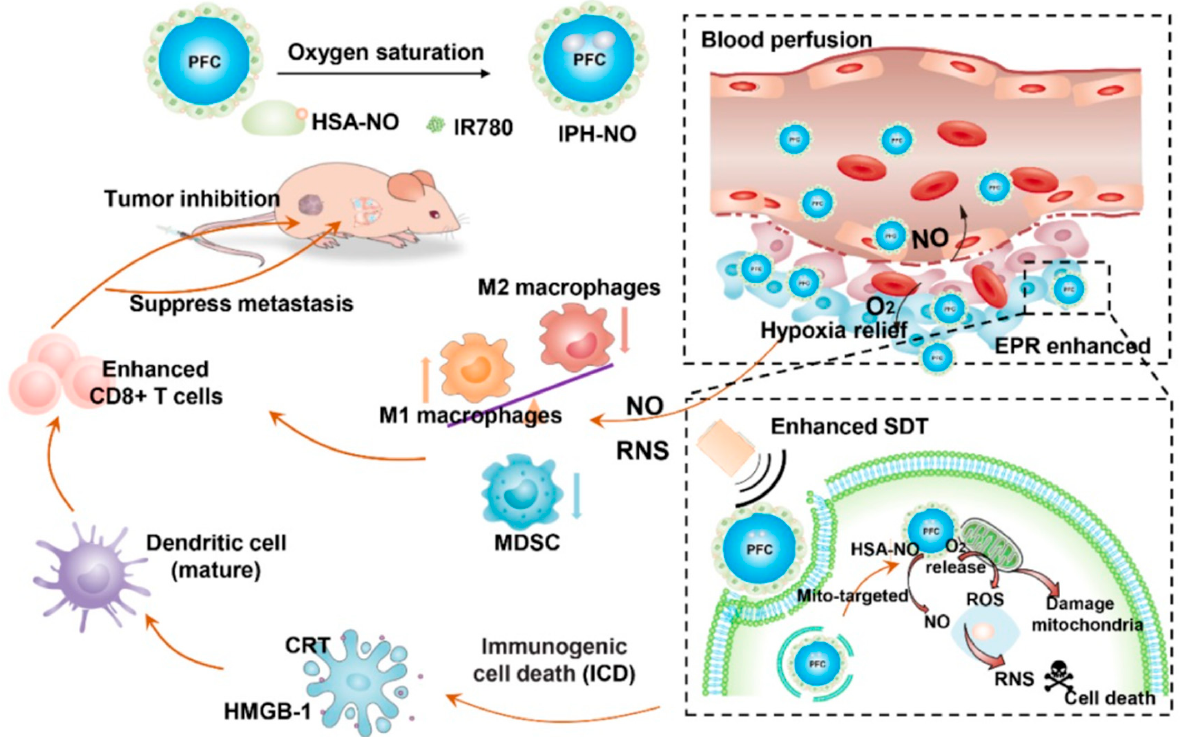
Figure 9. Scheme of magnetic responsive nanoparticles for cancer therapy, where immune activation, inhibition of primary tumor, and metastasis to the lung were the main underlying modulating progress. Reprinted with permission from Ref. [85]. Copyright 2021, Guo, H.